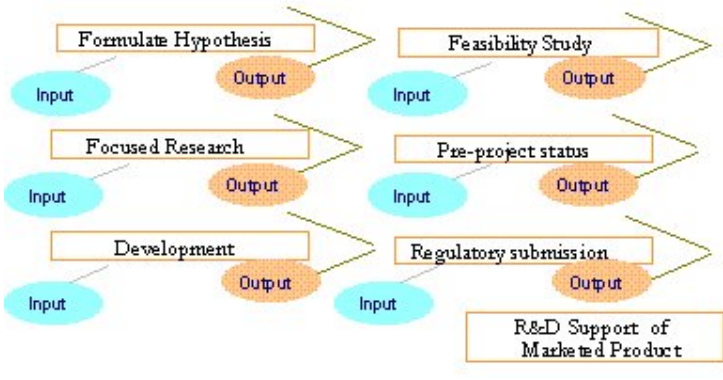
Figure 4 Process example – drug